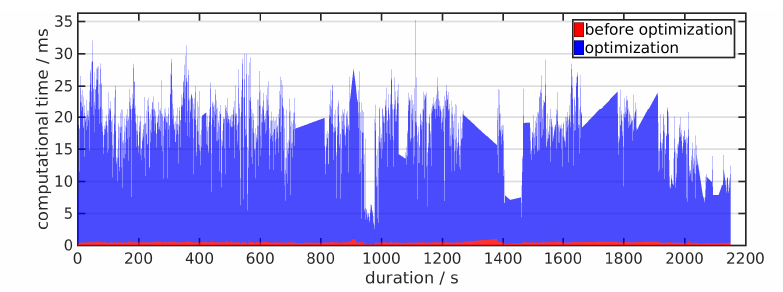
Figure 7. Computational time of the fusion process tested on KAIST dataset. The red component denotes the time cost on “measurement alignment” and “degeneration detection”. Although the blue component denotes the time cost on degeneration-aware batch